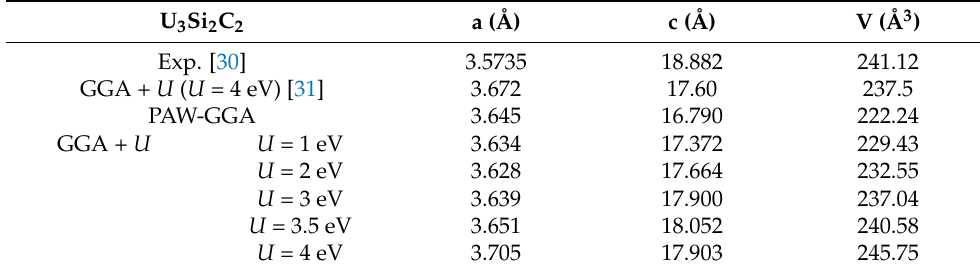
Figure 1. The crystal structure of U 3 Si 2 C 2 (blue: uranium; grey: carbon; yellow: silicon). Table 1. The experimental and calculated values of lattice parameters a, c (Å) and the cell volume (Å 3 ) of of U 3 Si 2 C 2 calculated by changing U